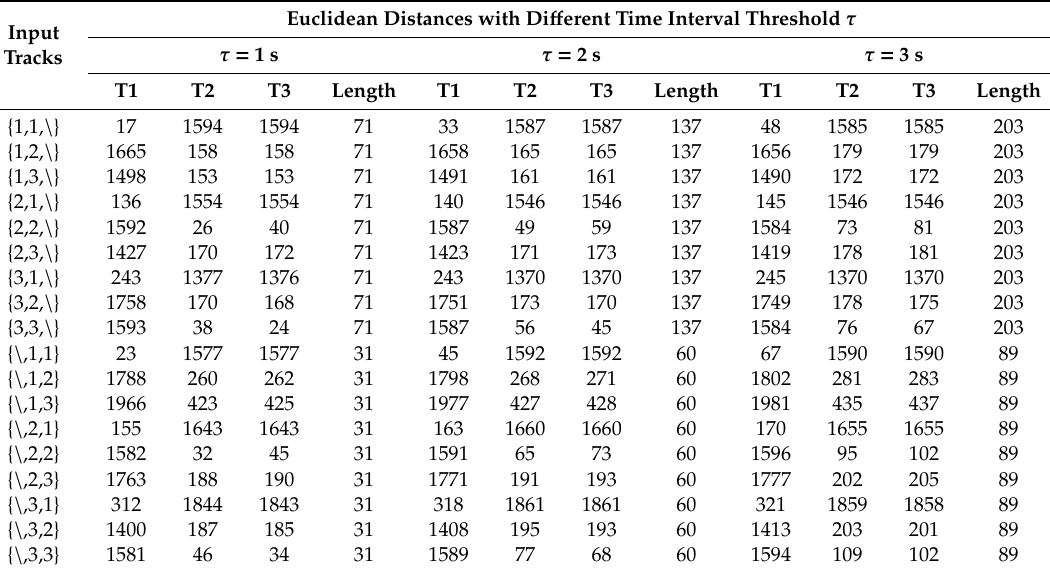
Table 2. Performance of pairwise fusion model with different parameters.